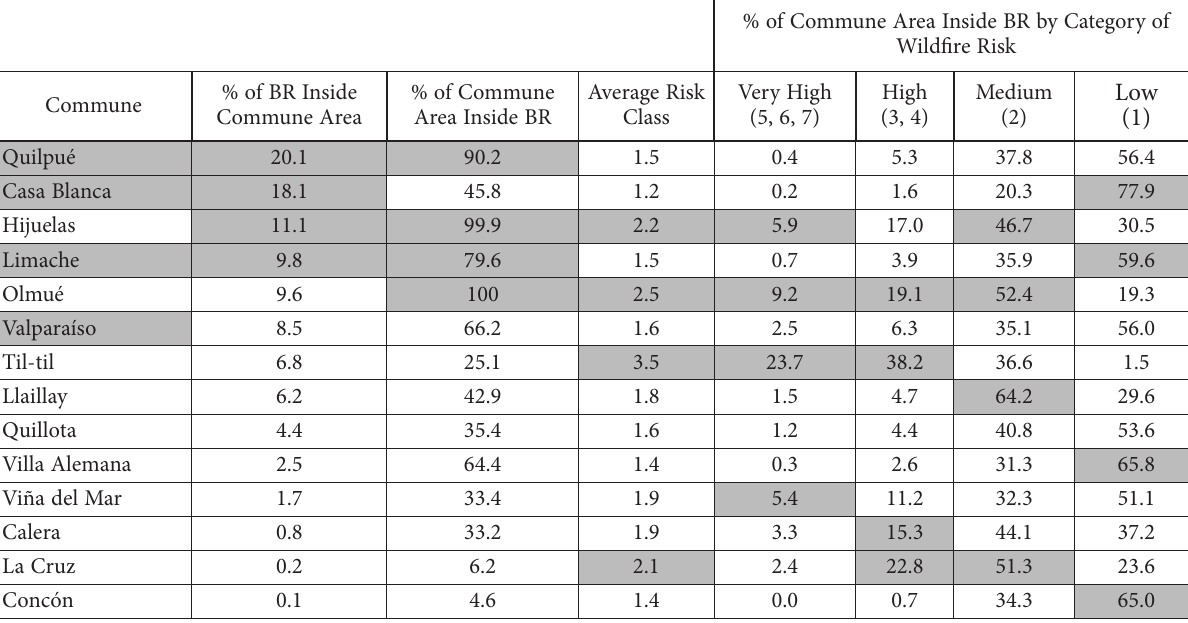
Table 3. Local government units overlapping the BR and their wildfire risk